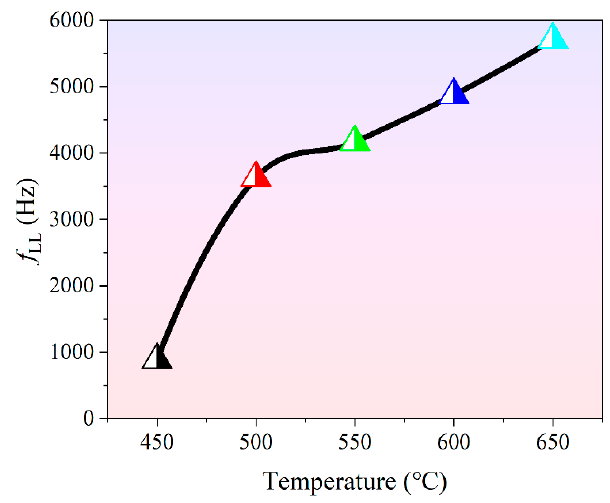
Figure 4. Lower limit frequency ( f LL ) of the BGTN − 0.2Cr ceramic as a function of temperature.